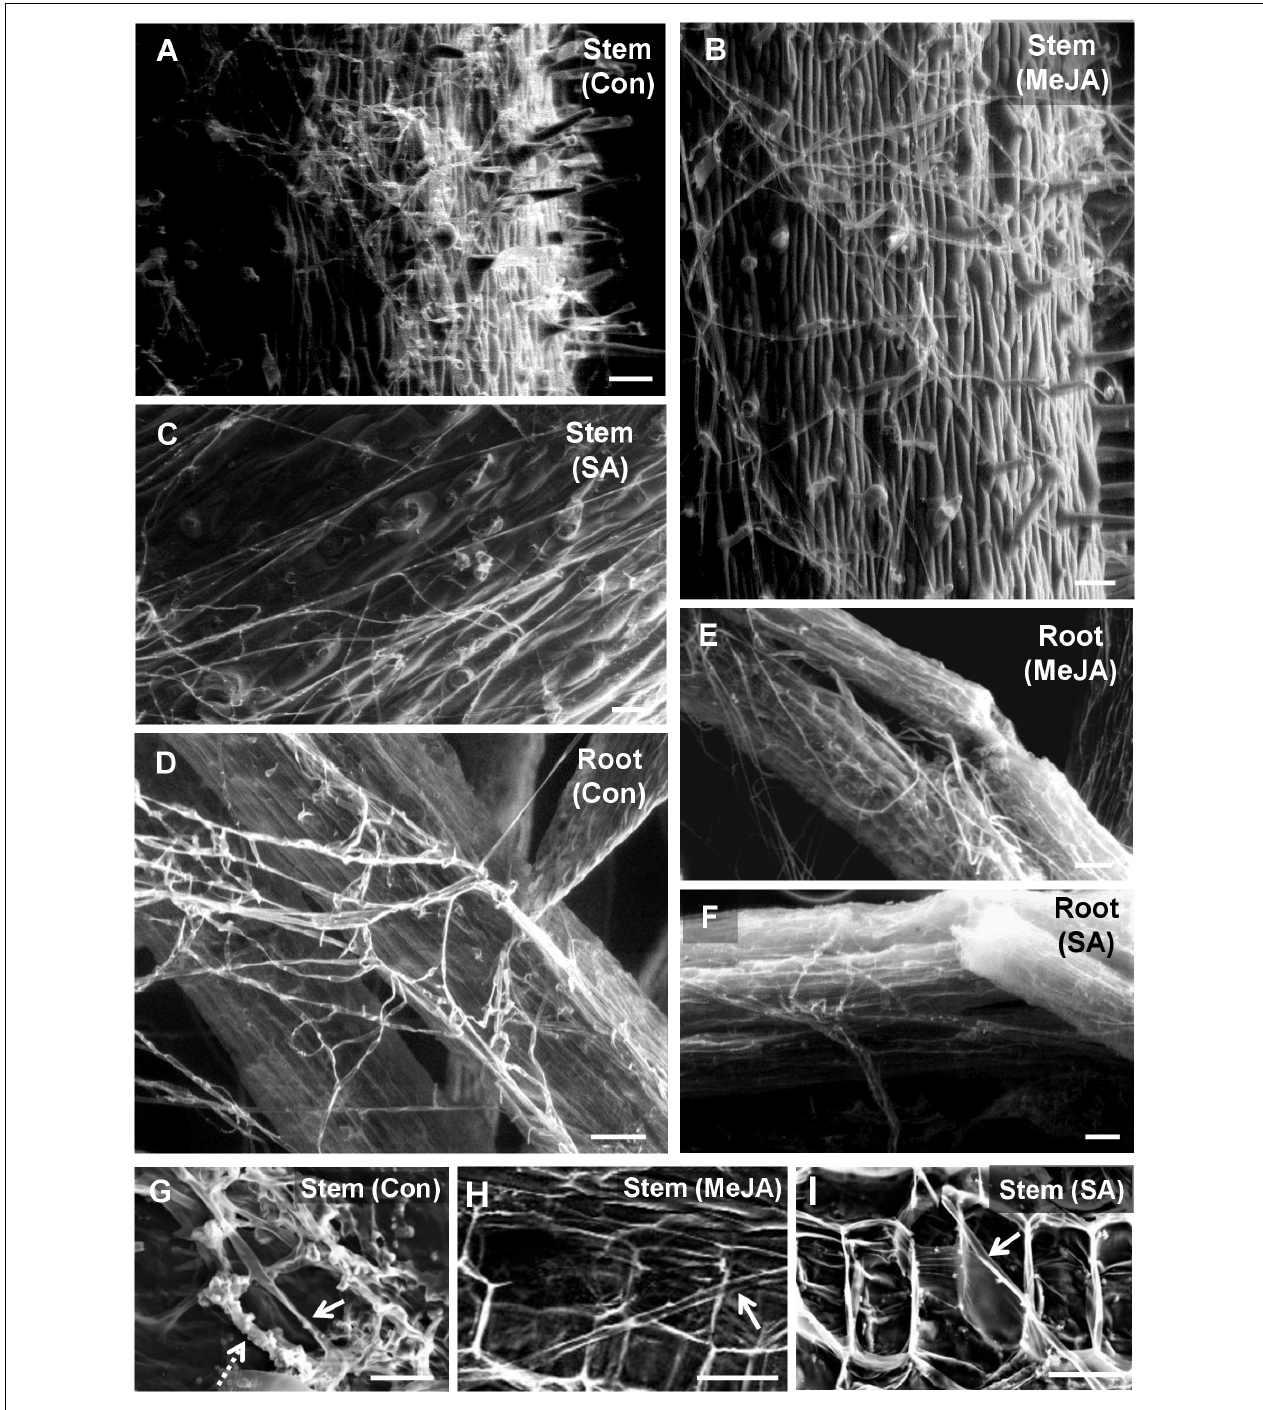
FIGURE 5 | Scanning electron microscopy of tomato stem and root surfaces showing differential behavior of R. solani hyphae at 2 days post-inoculation. (A) Profuse growth of hyphae covering the stem surface of control plants at 48 hpi forming tangled mats at places. (B) Significantly less growth of hyphae on the stem surface of MeJA pre-treated plants showing loose hyphal network. (C) SA pre-treated stem surface showing least hyphal load with the hyphae running straight without forming hyphal network (D) Roots of control plant showing a significant amount of thick hyphal growth on the surface, whereas a minimal growth of hyphae is found on MeJA-primed roots (E) , and even less on SA-primed roots (F) . Bar = 100 µ m (G) Regular occurrence of intracellular (solid arrow) and thick bunches of intercellular hyphae outlining the individual cells (dashed arrow) within the stem cortical tissue as seen in the transverse section through the stem at 48 hpi. (H,I) Rare presence of thin intracellular hyphae (arrow) in certain regions of stem cortical tissue in MeJA (H) and SA (I) -primed pants, though at most regions, in the cortical tissues there was absence of any hyphae at 48 hpi. Bars = 50 µ m.